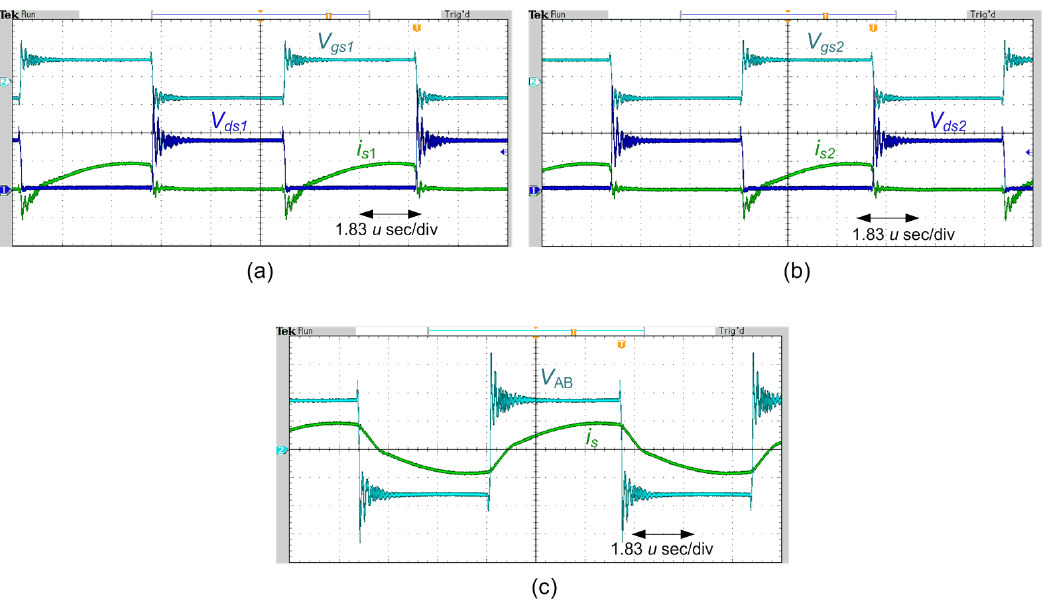
Figure 10. Experimental waveforms at V 1 = 40 V, V 2 = 44 V for 250 Watt load ( a ) V gs 1 : (25 V/div), V ds 1 : (50 V/div), i S 1 : (10 Amp/ div); ( b ) V gs 2 :(25 V/div), V ds 2 : (50 V/div), i S 2 :(10 Amp/div); ( c ) V AB : voltage across inverter (25 V/div), i s : resonant current (10 Amp /div).